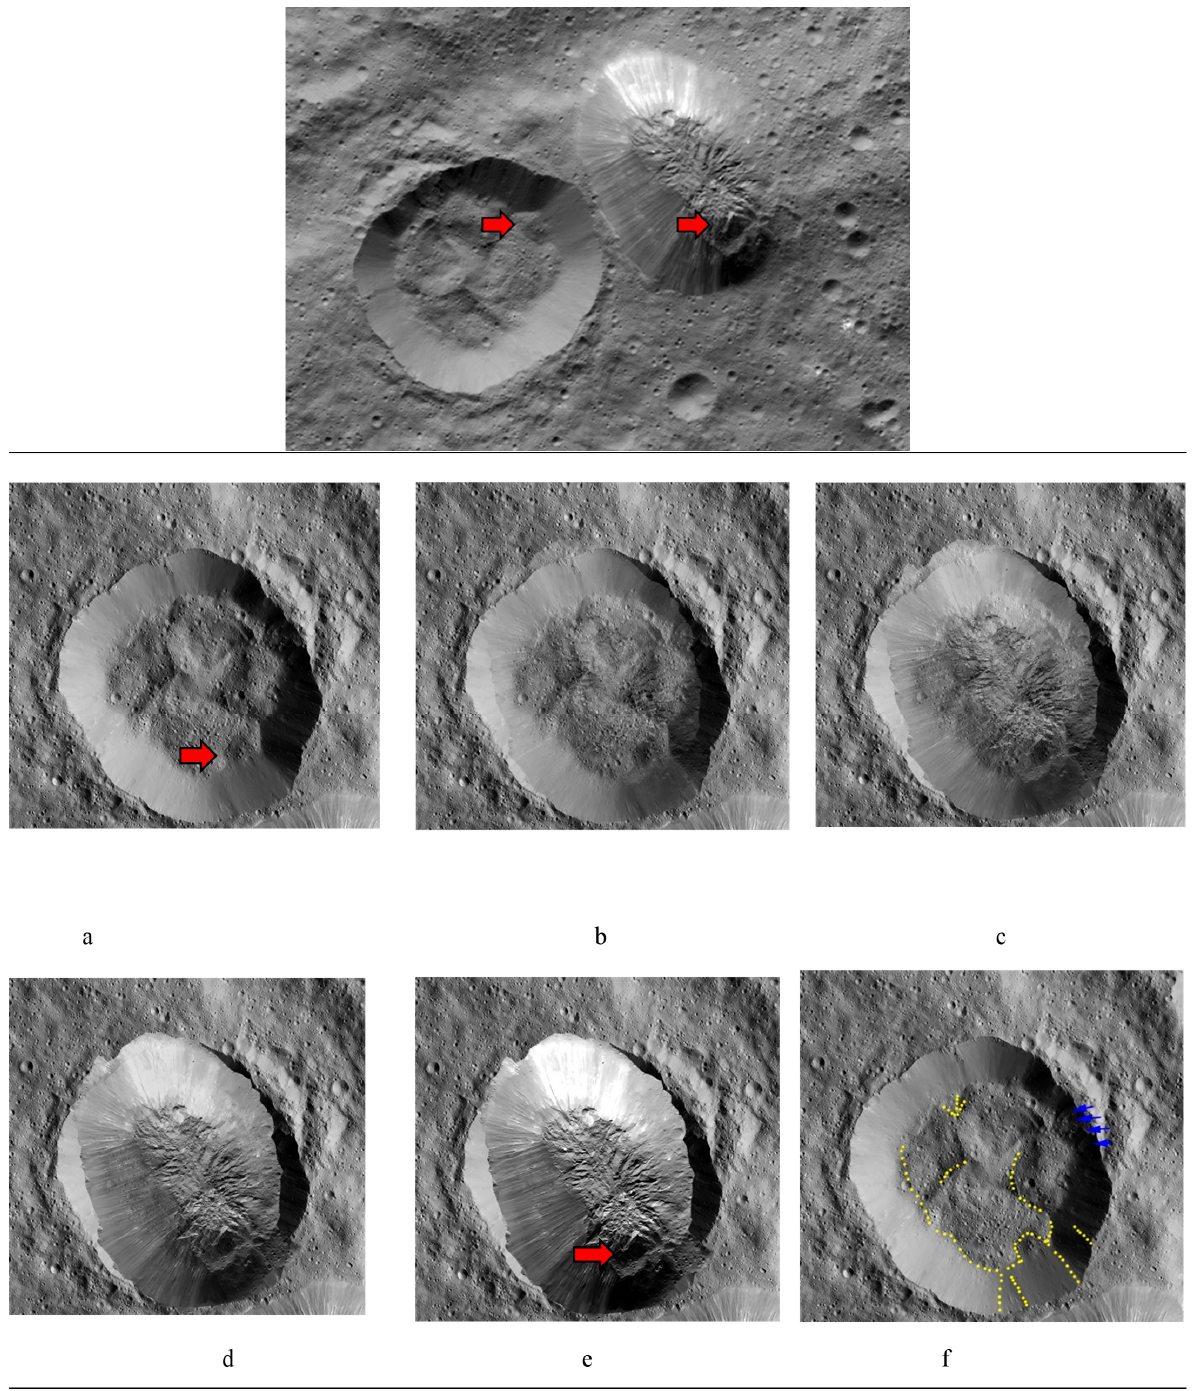
Figure 8. Qualitative 2D analysis of gradual overlapping of Ahuna Mons and Crater B. Top image: original image for reference. In red arrows, squared formations present in both Crater B and Ahuna Mons. Overlapping sequence of placing Ahuna Mons over Crater B making squared formations coincide. Crater B 100% ( a ), at 25% superimposed Ahuna Mons ( b ), at 50% ( c ), at 75% ( d ), and at 100% ( e ). ( f ) Image of Crater B shows some examples of the overlapping features between Ahuna Mons and Crater B (yellow dots) with Ahuna Mons (comparison of ( e ) and ( a ) images), especially the south region with particular squared formation. Blue arrows show how this side is also in both cases the more cratered one. Original images credit: NASA/JPL-Caltech/UCLA/MPS/DLR/IDA (130–140